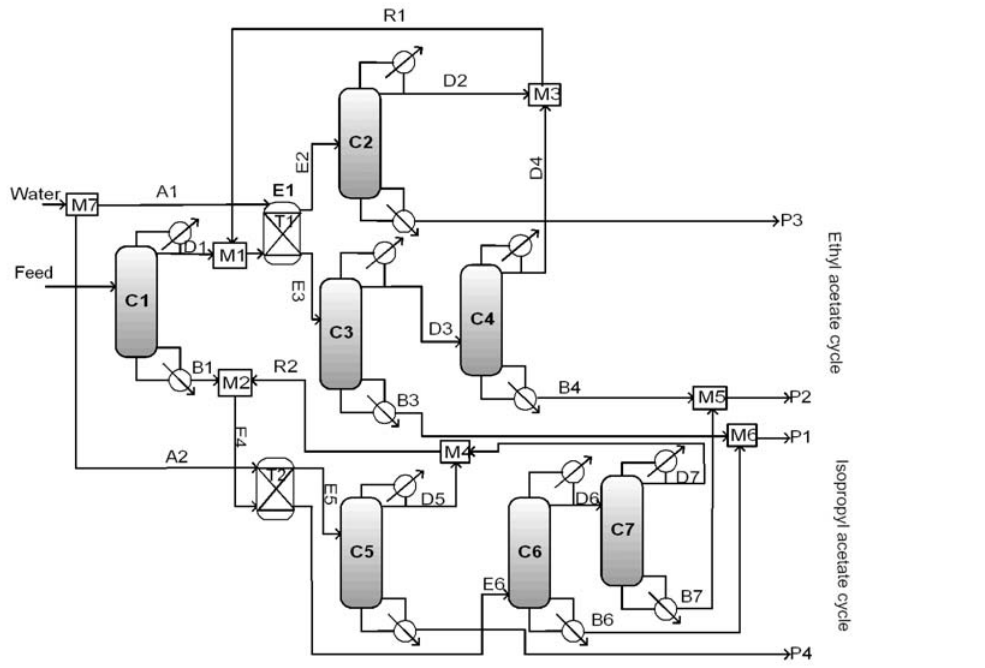
Fig. 1 Ternary cut scheme for the separation of the waste solvent stream